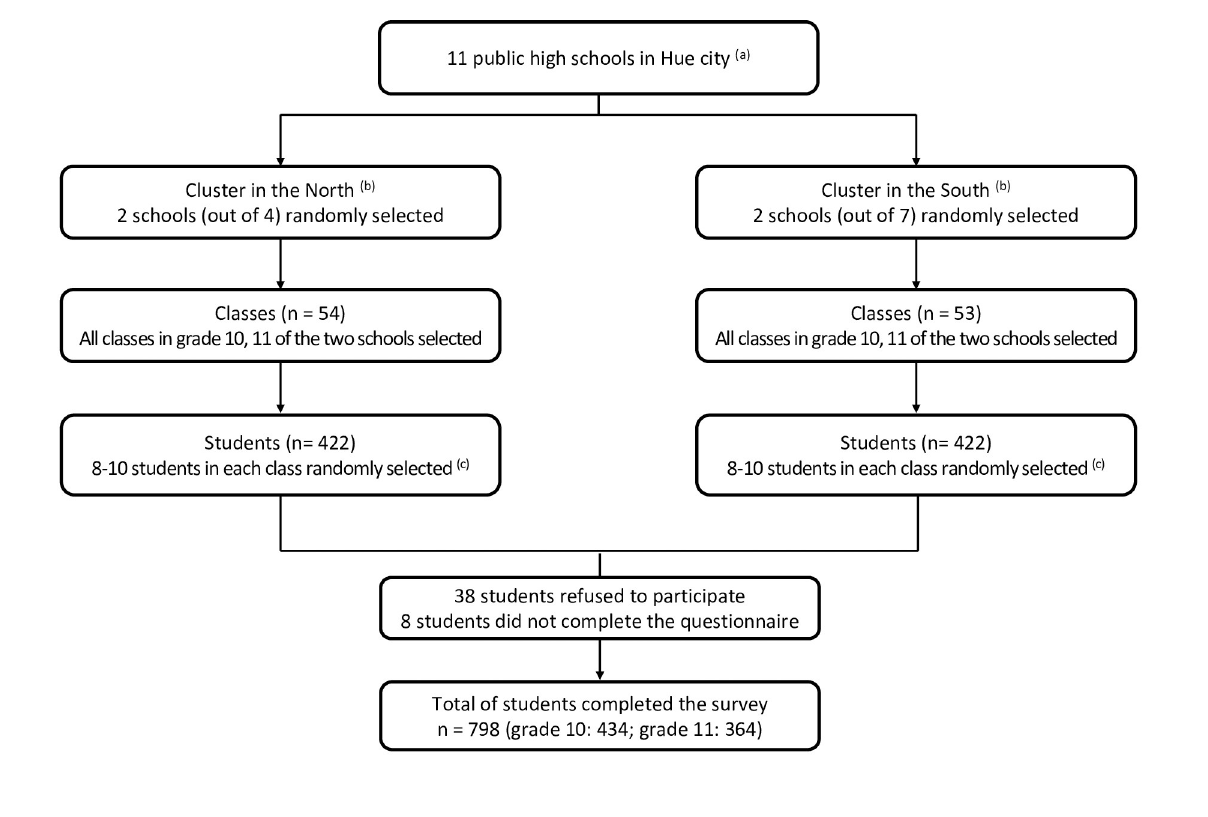
Fig 1. Flow chart of participants selected in this